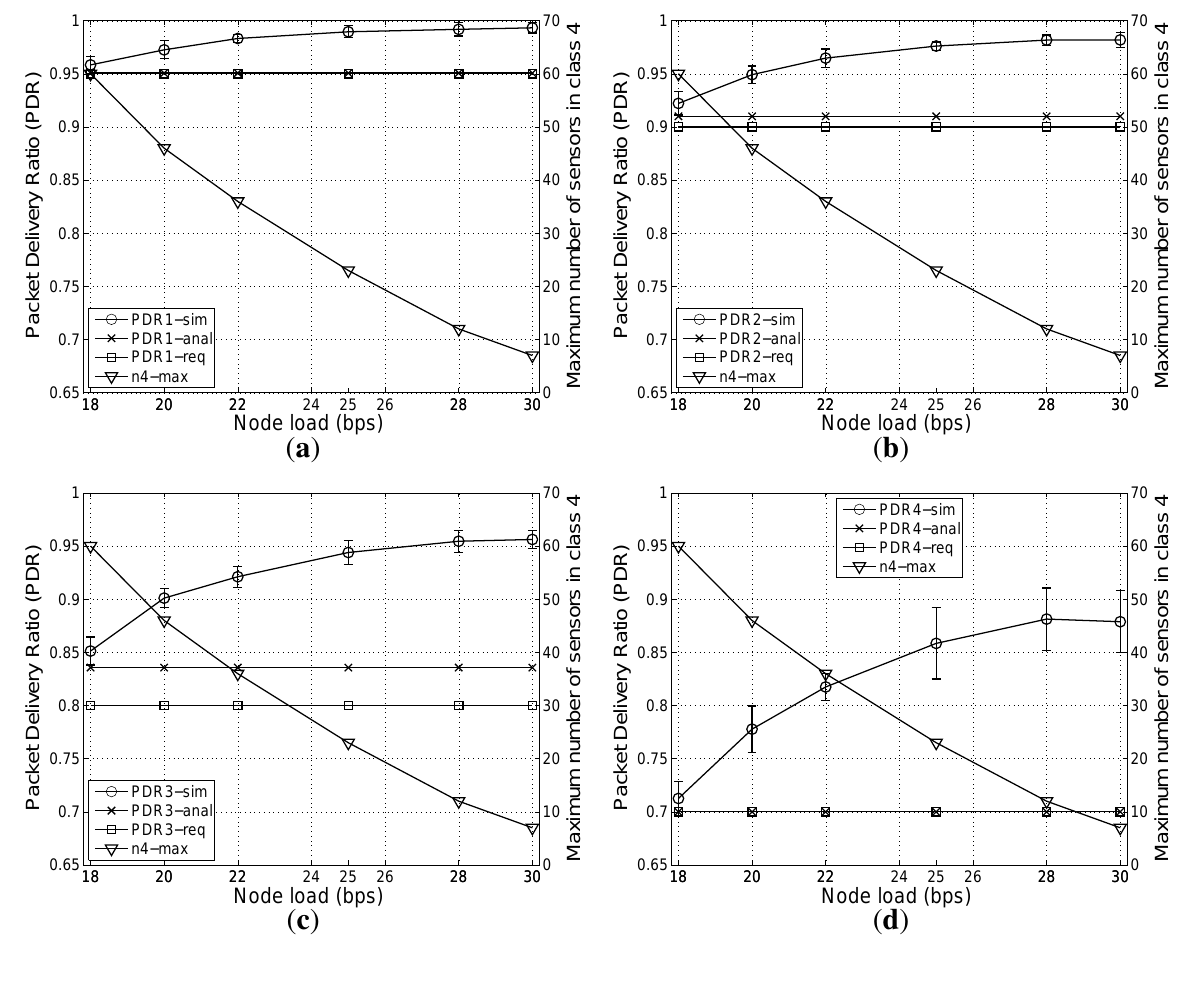
Figure 4. The effects of node load on the PDR (mean +/- standard deviation) achieved from the greedy algorithm and from simulations and the maximum number of nodes in class Q with n = 5, n = 15, n = 20. ( a ) For class Q 1 2 3 class Q 4